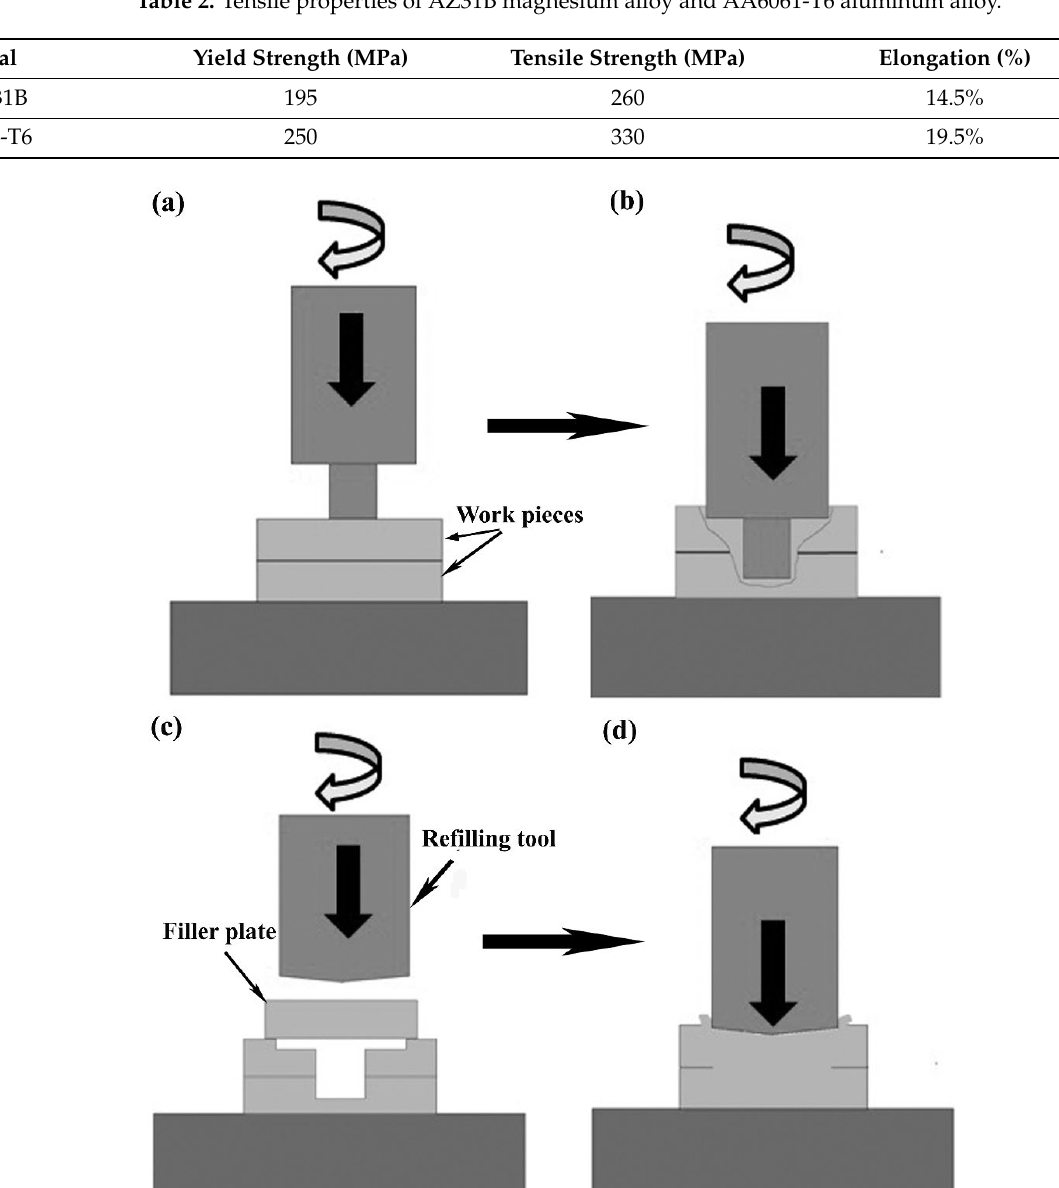
Figure 1. Schematic illustration of R-FSSW. ( a ) Sheets are fixed and the tool is rotated. ( b ) Tool is inserted into the sheets. ( c ) The tool is removed, and a filler plate is inserted. ( d ) Filler plate is inserted into the probe hole by the friction forming tool. Table 1. Chemical composition of the magnesium alloy AZ31B and aluminum alloy 6061-T6 (in wt.%).